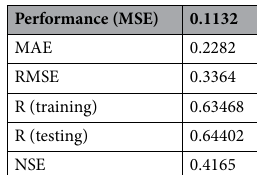
Table 6. Evaluation using SCG backpropagation.